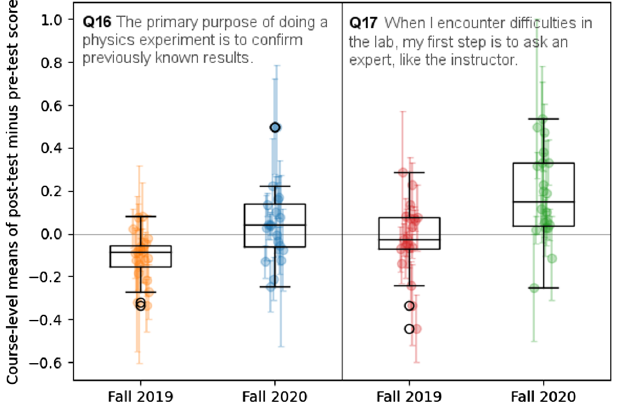
FIG. 3. Box and whisker plots illustrating the distribution of student post-test minus pretest scores on questions 16 and 17 (left and right boxes respectively) in Fall 2019 (left) and Fall 2020 (right). These items are those from Fig. 2(b) that show the largest effect size in 2020 compared to 2019. The center, horizontal line of each box corresponds to the median student difference in scores, while the lower and upper edges of the box correspond to the first and third quartiles, respectively. The whisker length is the furthest data point within 1.5 times the interquartile range from the edge of the box. Data points outside this range are indicated with open black circles. Overlaid on each box and whisker plot is plotted, as colored circles, the mean score for each course, with error bars indicating the standard error of the